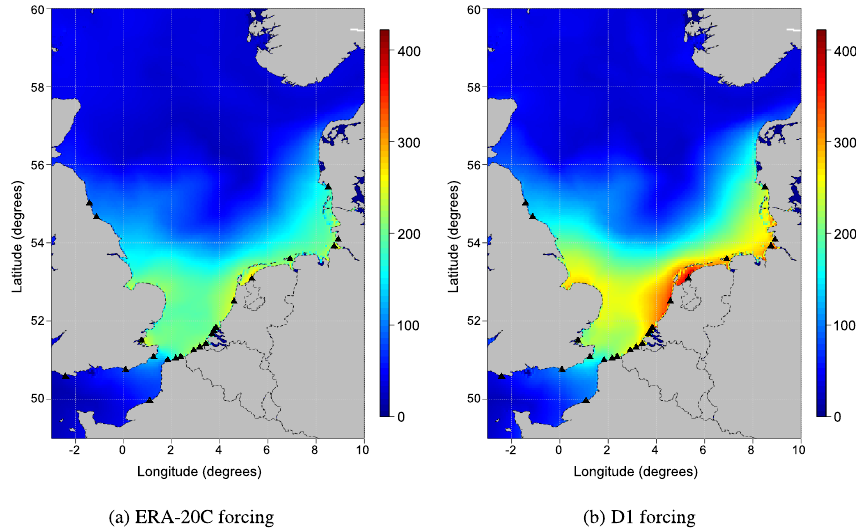
Figure 14. The highest simulated storm surges (centimetres) obtained for the period from 30 January to 2 February 1953, with the ERA-20C forcing (a) and with the D1 forcing (b) along the southern North Sea